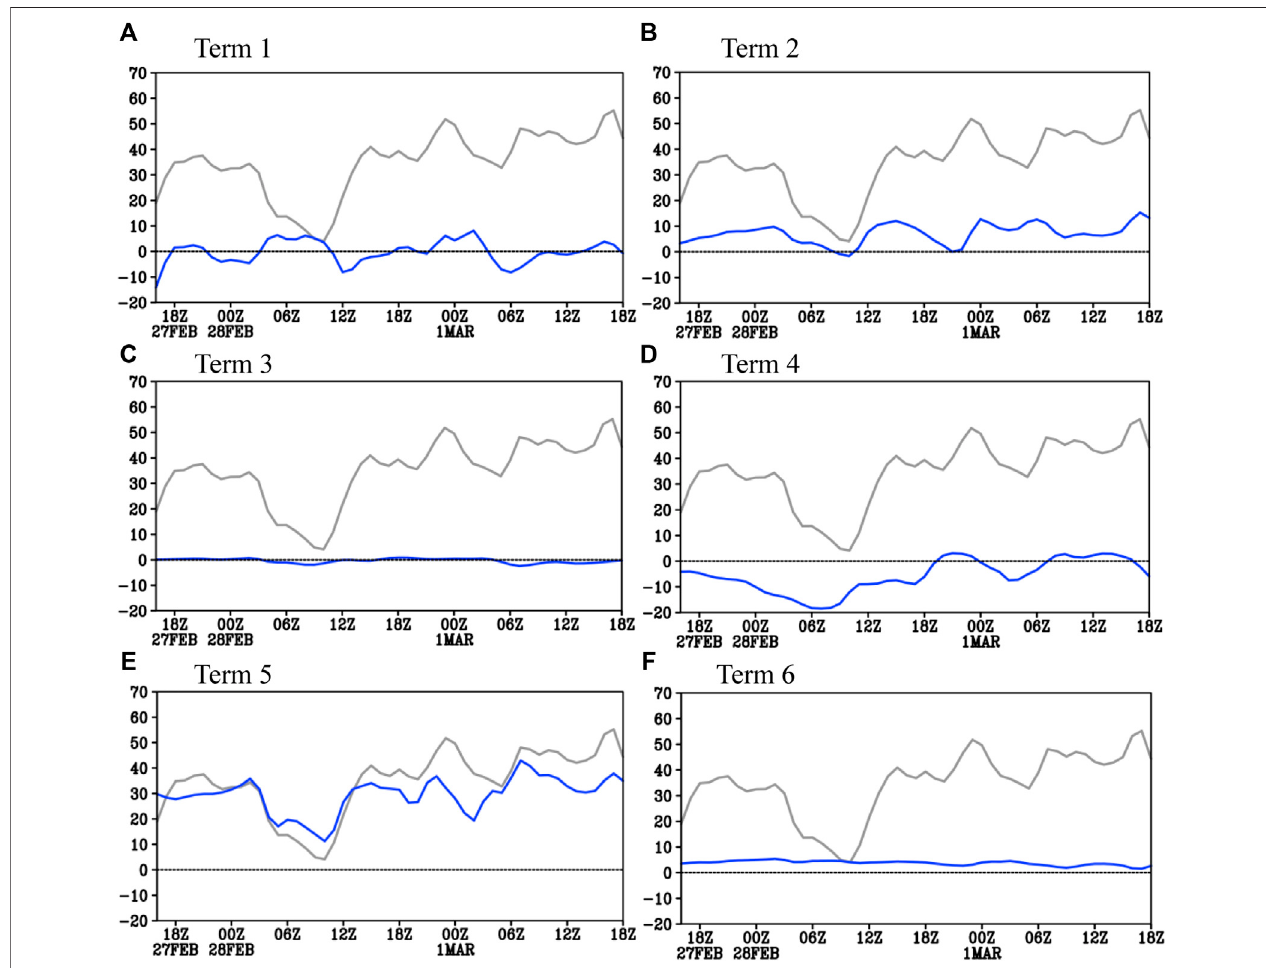
FIGURE 3 | Verticalintegral(from950hPato850hPa)ofthekineticbudgetterms(units:Js -1 m -2 ),wherethegreysolidlinesshowthesumofTerms1-6,blackdashedlines mark thevalueof0, and bluesolid linesrepresenteach budgetterm. (A) Term1: Thecyclone ’ sdisplacement, (B) Term2:Therotational wind ’ stransport, (C) Term3: The divergent wind ’ s transport, (D) Term4: The vertical transport, (E) Term5: The rotational wind by pressure gradient force, (F) Term6: The divergent wind by pressure gradient force.